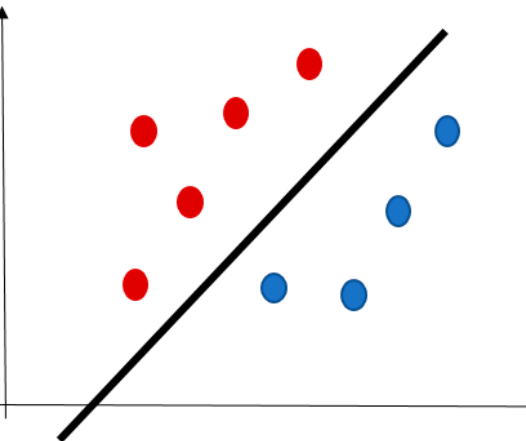
Figure 2. An example of SVM hyperplane (red and blue points are the training records).